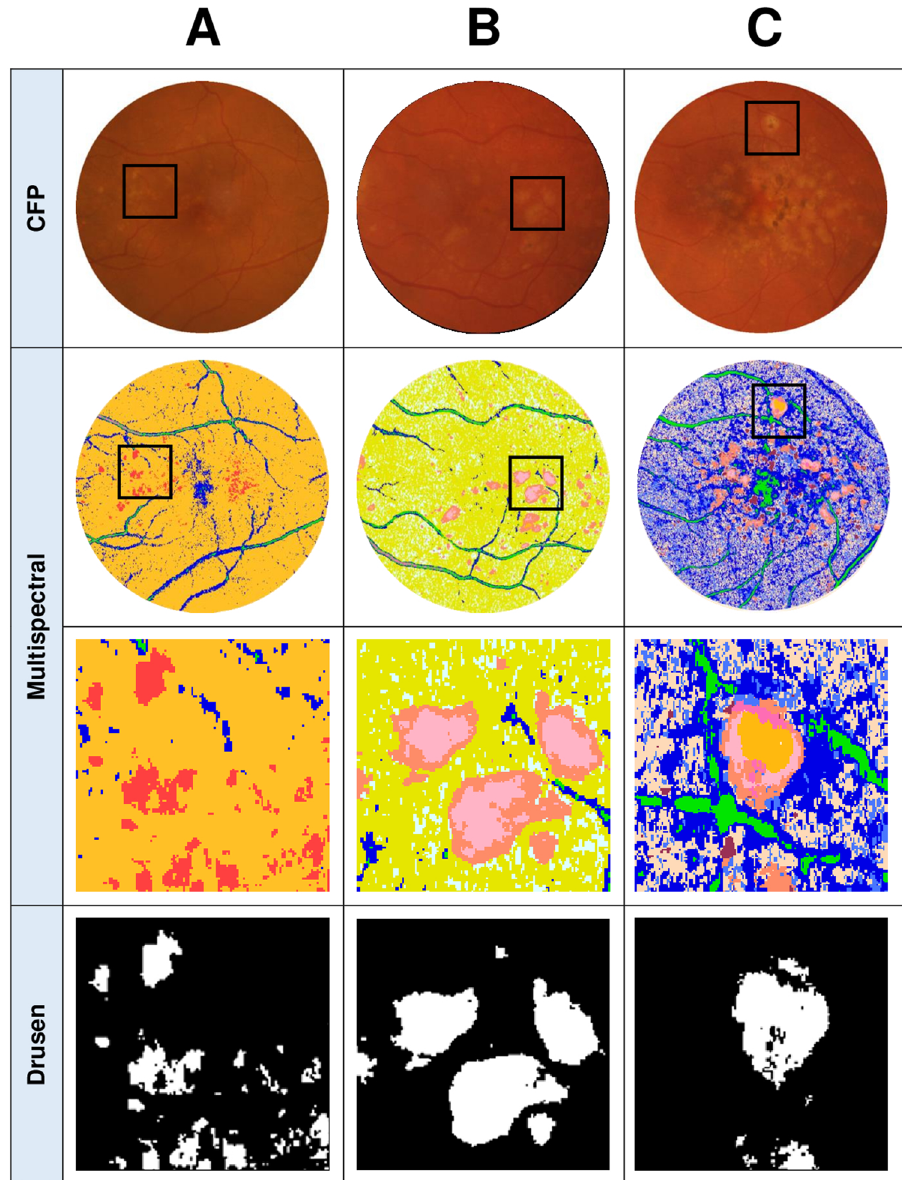
Figure 3. CFPs and OCT line scans from three different eyes and their corresponding pseudocolored images (derived from multispectral image analysis) showcasing the different types of drusen spectral theme classes that emerged. ( A ): An example of an eye where a single drusen spectral theme classes (red) emerged from the pseudocolored image. ( B ): An example where two separable spectral theme classes for drusen (pink and peach) emerged which were then pooled for the quantification of drusen area. ( C ): An example of an eye which yielded multiple spectral theme classes in the pseudocolored image for drusen (orange, light pink, and peach) as well as other AMD lesions such as pigmentary abnormalities (dark pink, maroon) that can be seen on the CFP and OCT (colored arrows indicate each spectral theme class relative to OCT line scan). Only the spectral theme classes identified as drusen were pooled for the quantification of drusen area (final row). Boxes in CFP and multispectral images indicate locations of magnified images. Lines through magnified CFP images indicate location of OCT line